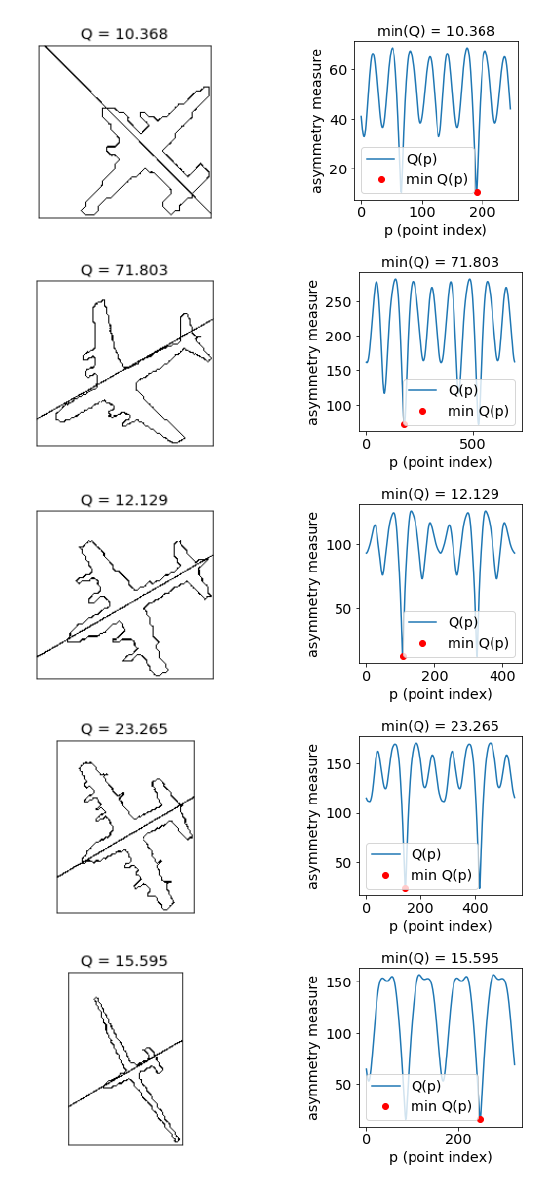
Figure 8. The first column consists of images with the symmetry axises of plane contours. Q is the asymmetry measure. The second column contains the assymetry measure of given contours from different contour points.